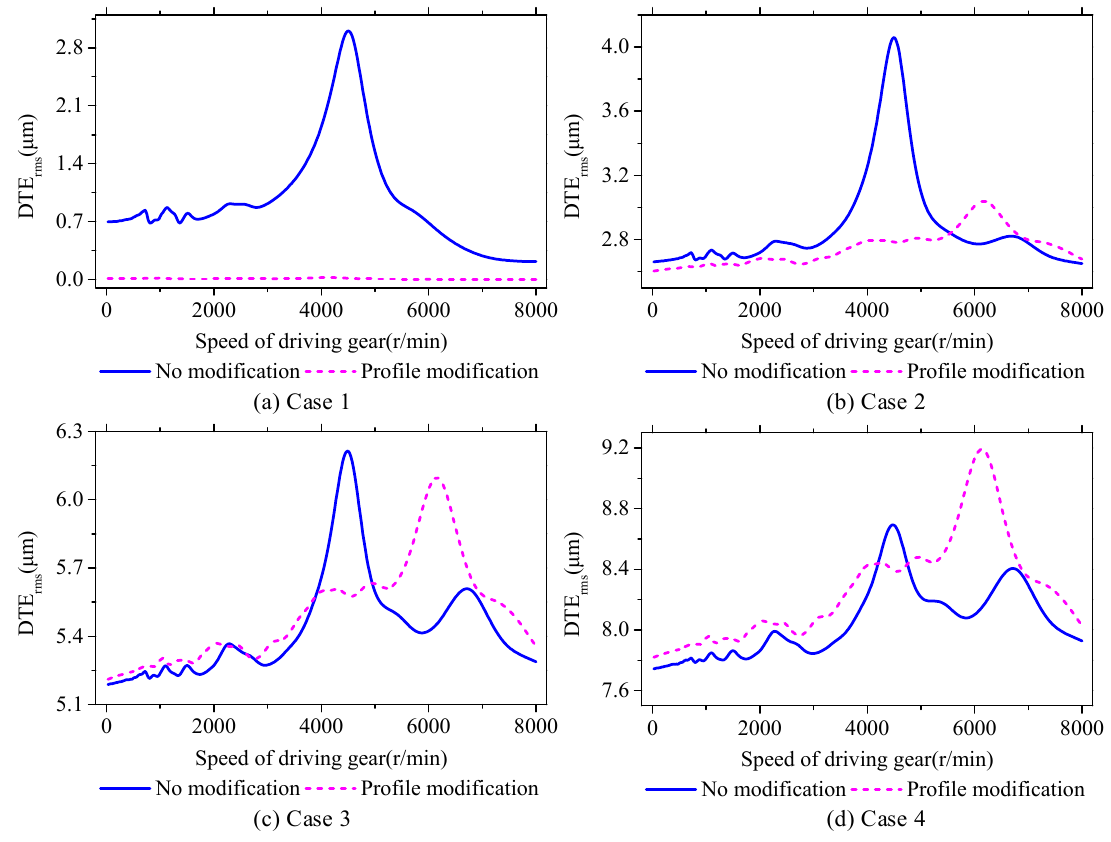
Figure 17. DTEs versus input speeds under different random cumulative pitch deviations conditions.